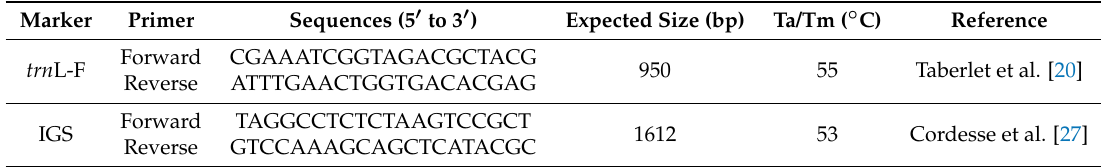
Table 2. Primers used for PCR amplification and for cycle